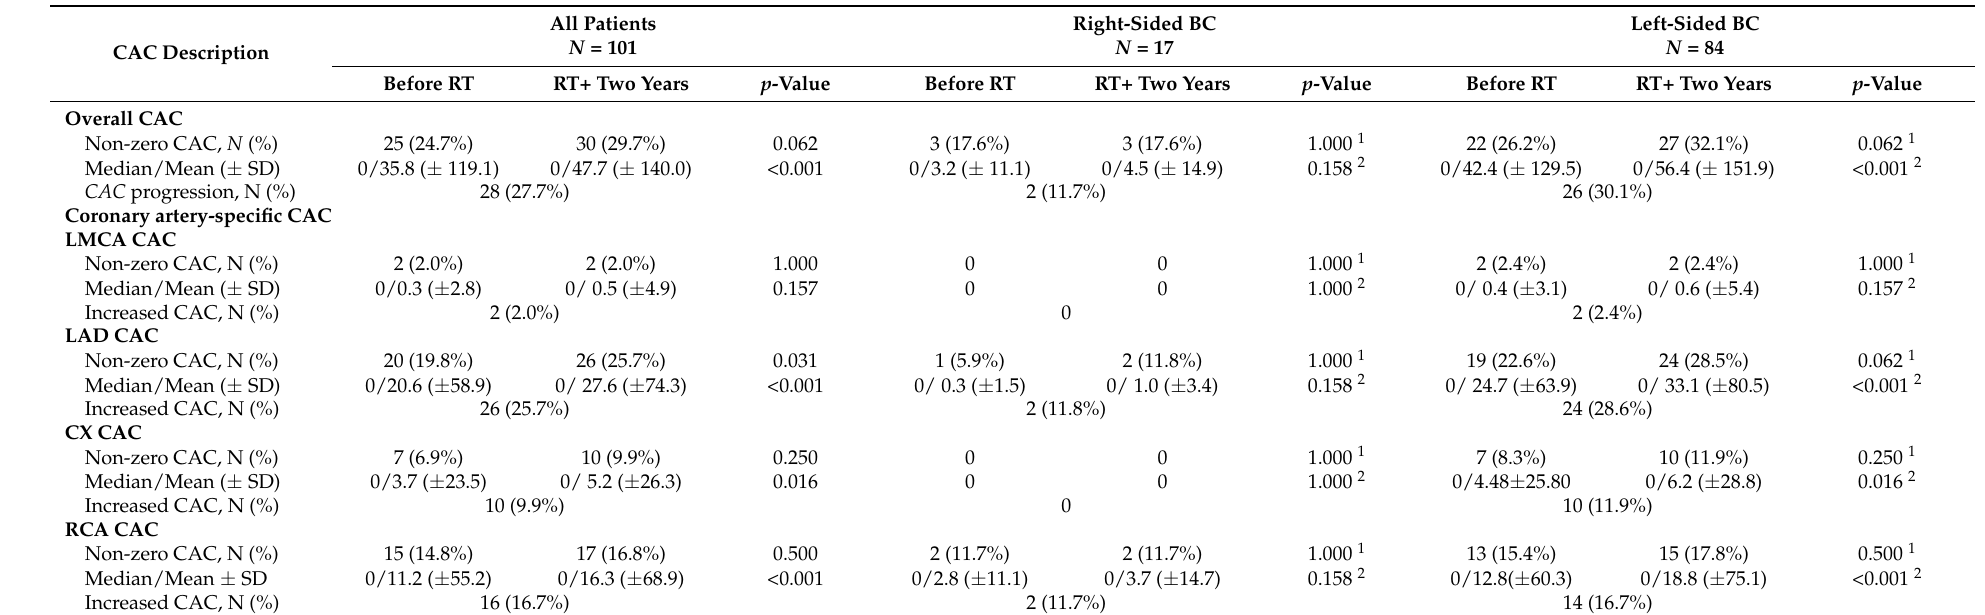
Table 3. Comparison of CAC (overall and by coronary artery) before RT and two years after